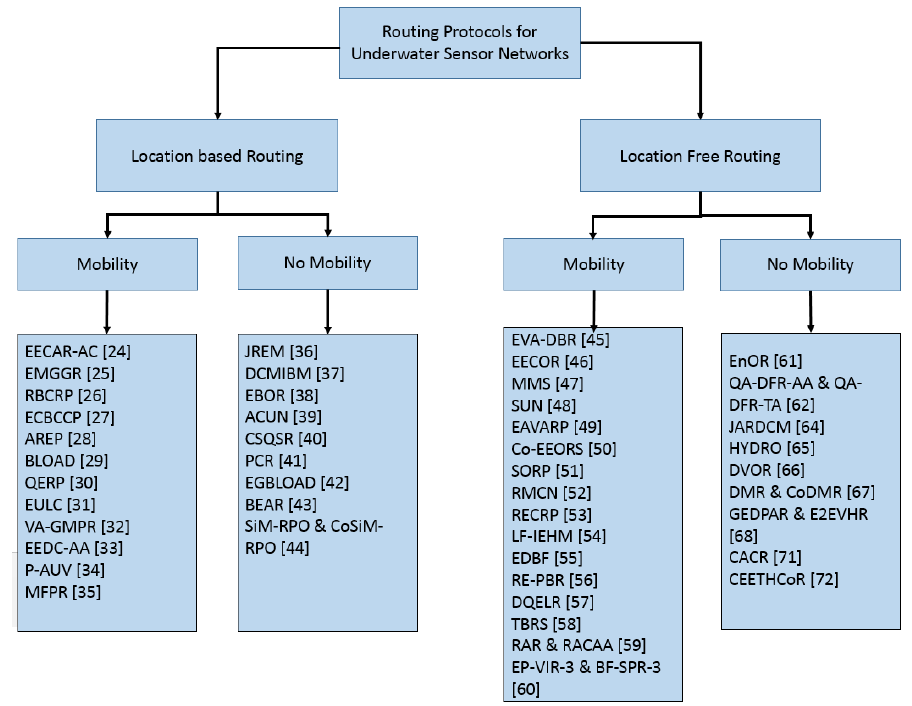
Figure 3. Classification of routing protocols based on location requirement and mobility.